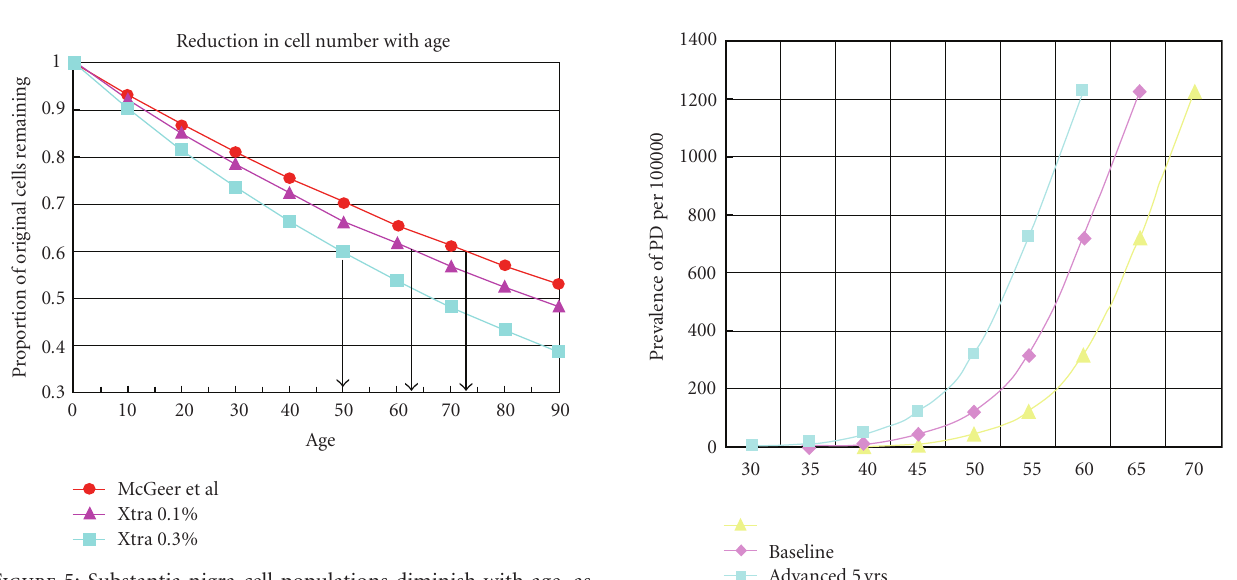
Figure 5: Substantia nigra cell populations diminish with age, as shown by McGeer et al. [31]. At about age 72, about 40% of the cells have been lost. If the decline is accelerated by 0.1% per year, such a loss would occur at about age 64.